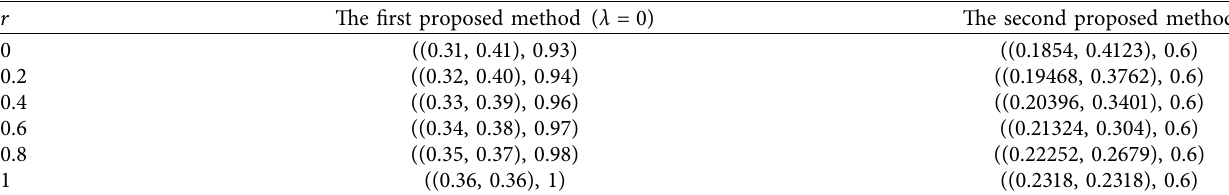
( r ) result using the two proposed methods ( λ � 0 ) . 3